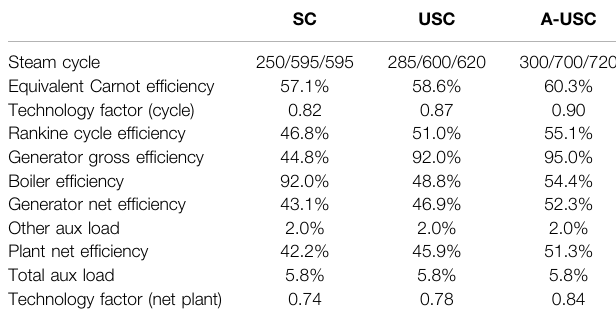
TABLE 2 | Conventional steam Rankine cycle power plant ef fi ciency